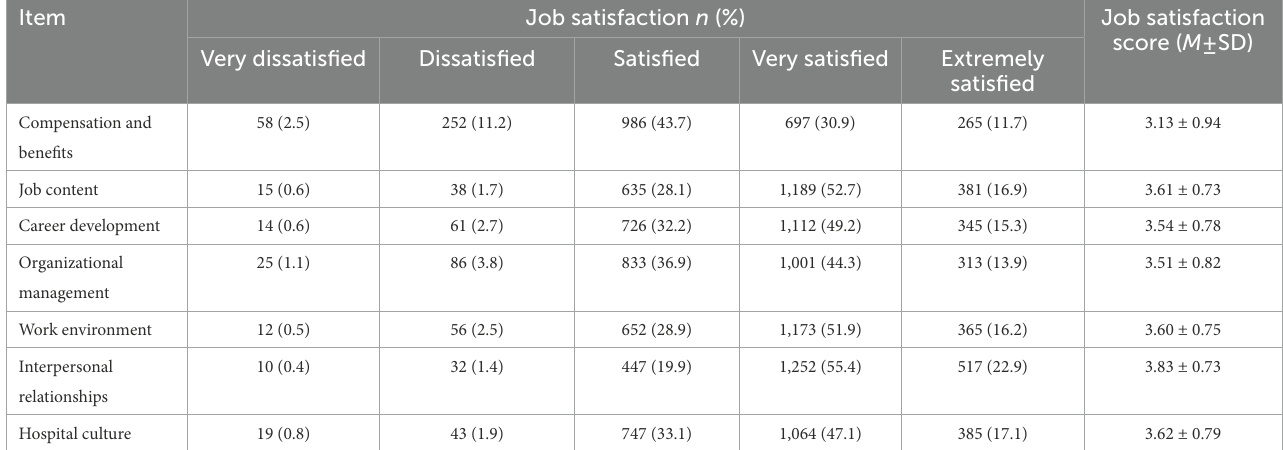
TABLE 2 Job satisfaction score for each